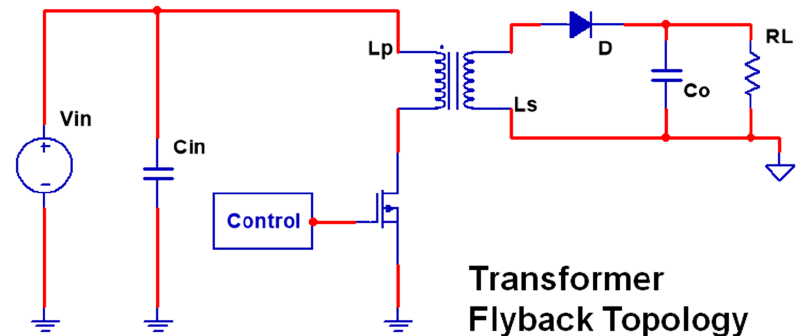
Figure 1. DC-to-DC converter with flyback topology.